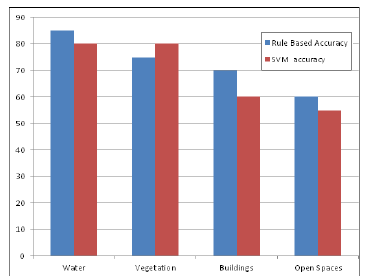
Figure 12: Urban Feature Extraction Accuracy Assessment Bar Plot